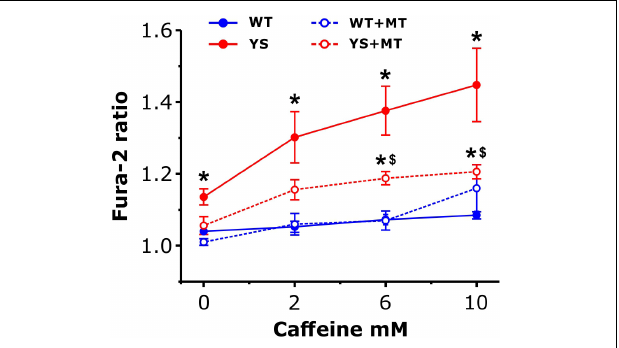
FIGURE 8 | Cytosolic free Ca 2 + concentrations in response to caffeine following pre-treatment with MitoTEMPO. Cytosolic Ca 2 + levels, determined as Fura-2 ratio, during exposure to increasing caffeine concentrations in control YS and WT fibers and in YS and WT fibers pre-treated with MitoTEMPO (MT) for 24 h. Data are shown as means ± SEM; ∗ p < 0.05, YS pre-treated and YS not pre-treated vs. WT; $ p < 0.05, YS pre-treated vs. YS not pre-treated. n = 5 fibers in each